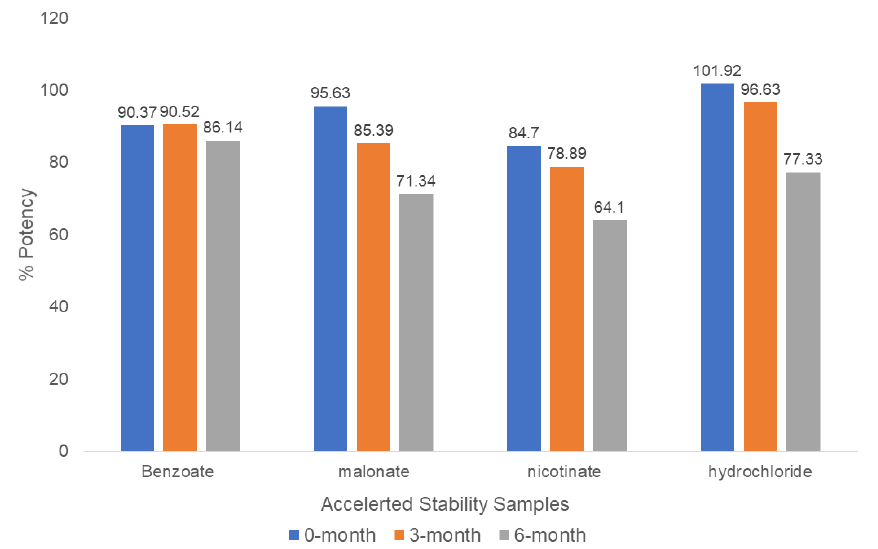
Figure 12 . Potencies determined in the accelerated stability studies for bedaquiline salts. The potencies of all bedaquiline salts declined under accelerated studies .